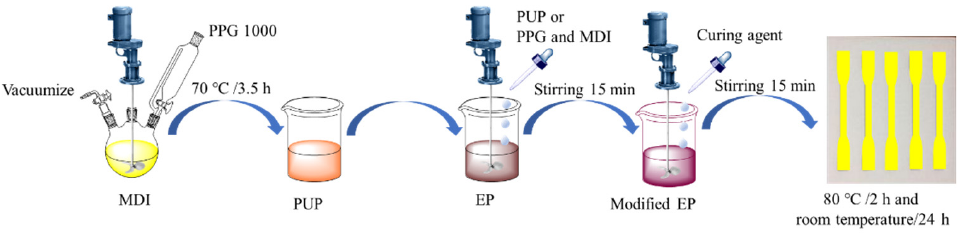
Figure 1. Preparation of samples.